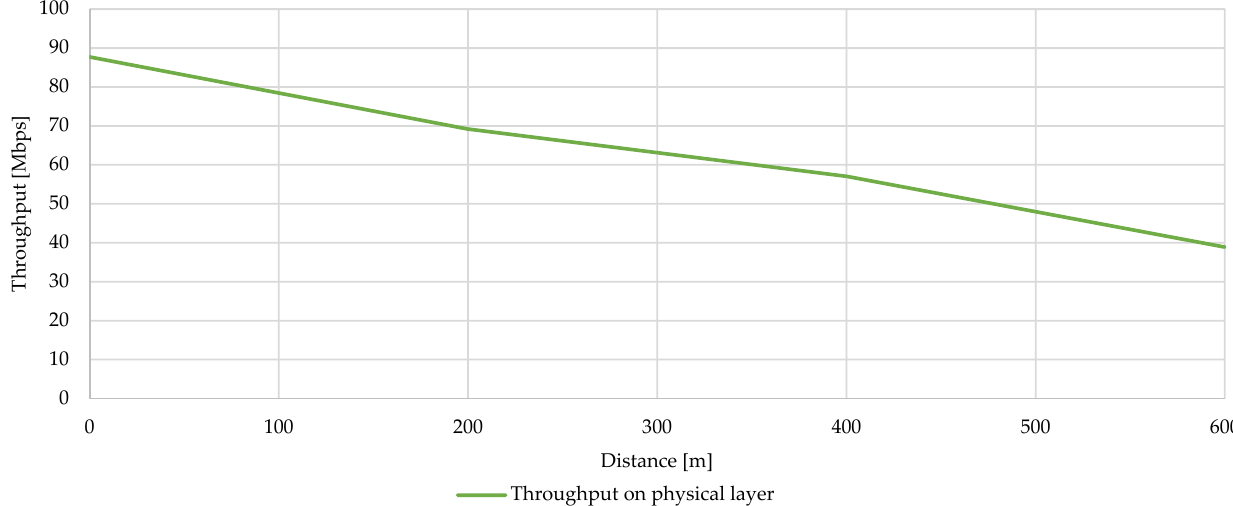
Figure 12. Comparison of simulated and measured results: (Simulation) NS-3 simulation of real topology with PLC model setup due to BPLC modems parameters; (Measurement) Throughput measurement on UDP layer in one direction in sub- sections—without repeaters.